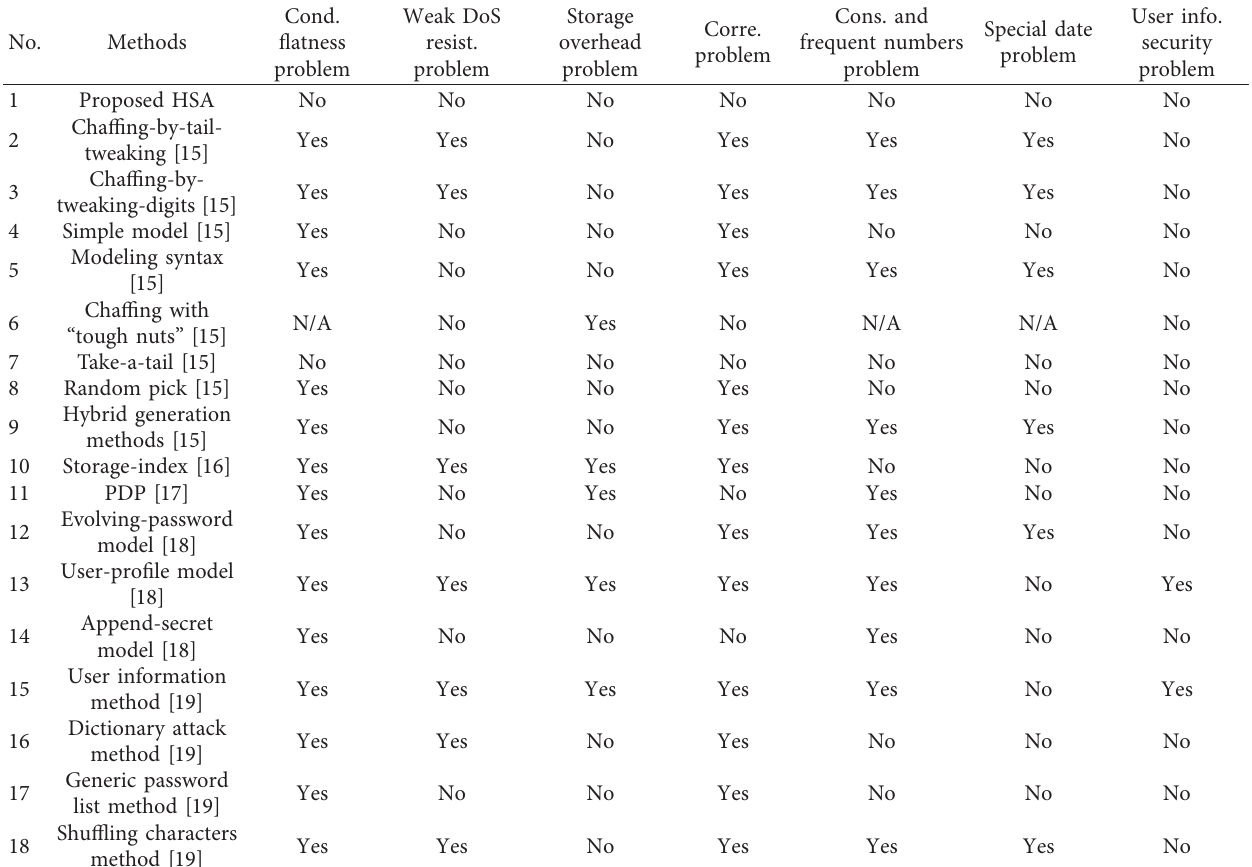
Table 3: A comparison in most pressing problems of honeyword